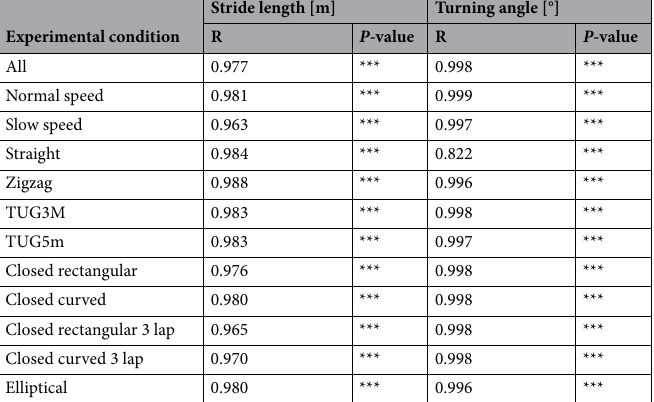
Table 3. Pearson’s product rate correlation coefficients R and p-value level between the proposed method and the golden standard in stride length and in the turning angle. These results are evaluated under the two walking speed conditions and the nine walking route conditions. *** P < 0.001.